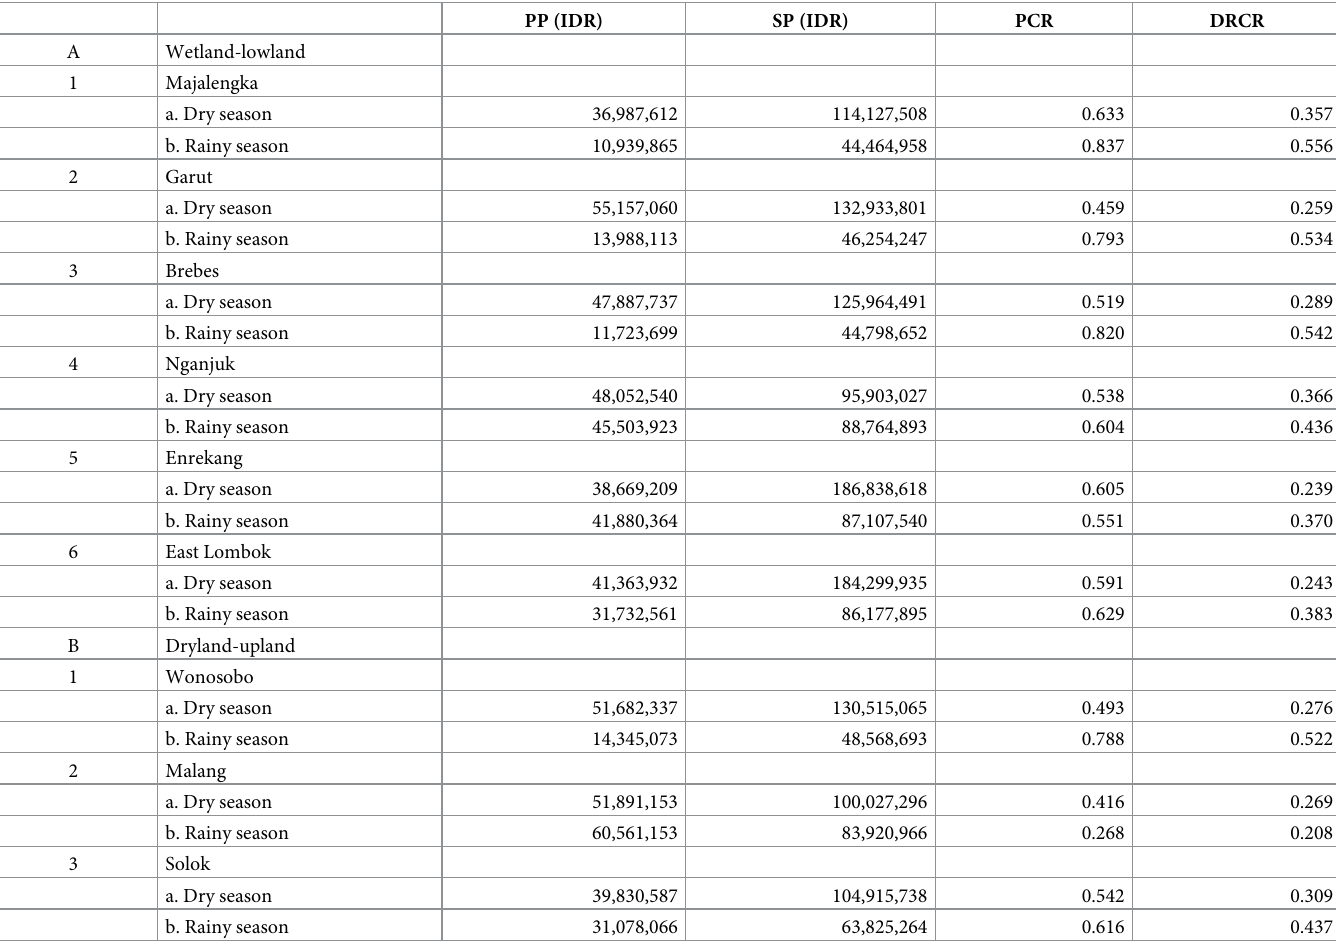
Table 3. Values of PP, SP, PCR, and DRCR of shallot farming per ha per season in Indonesia’s shallot production centers, dry season 2019 and rainy season 2019/